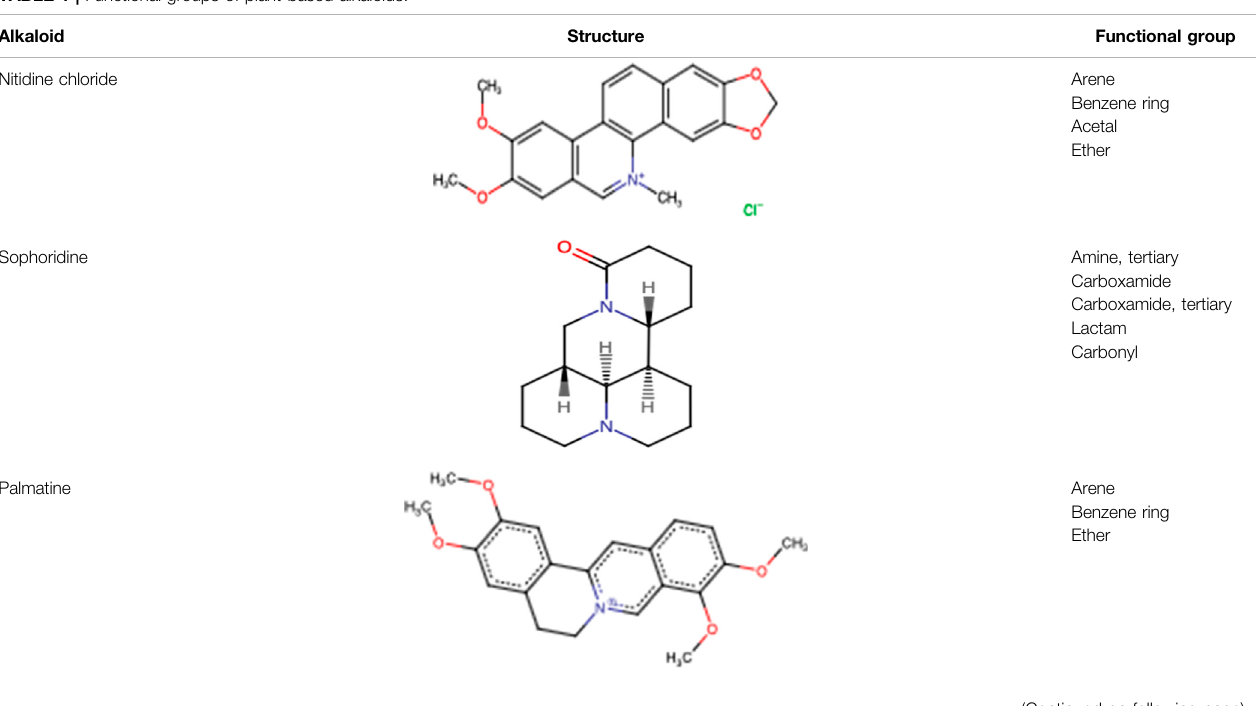
TABLE 1 | Functional groups of plant-based alkaloids.